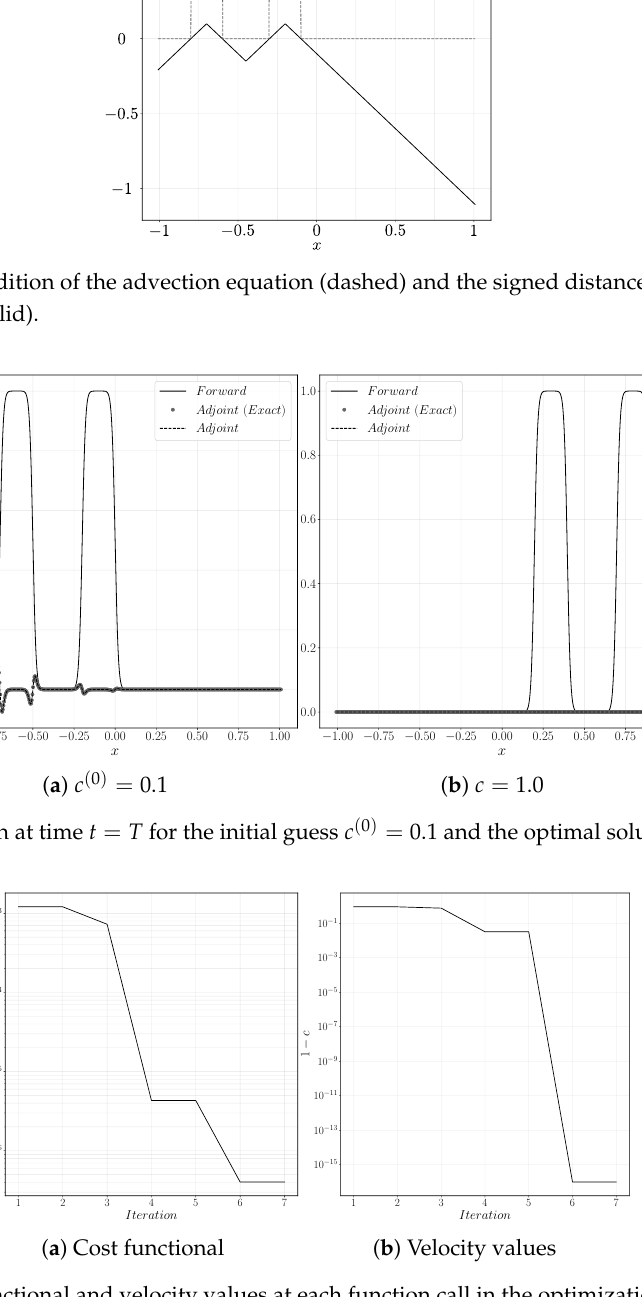
Figure 4. Cost functional and velocity values at each function call in the optimization